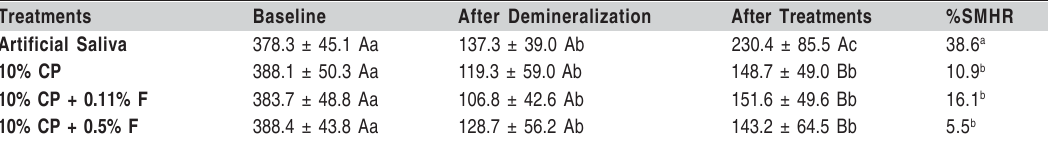
Table 1: Microhardness mean values at baseline, after demineralization and after experimental treatments (means ± SD, n=17), and percentage of surface microhardness recovery (%SMHR).